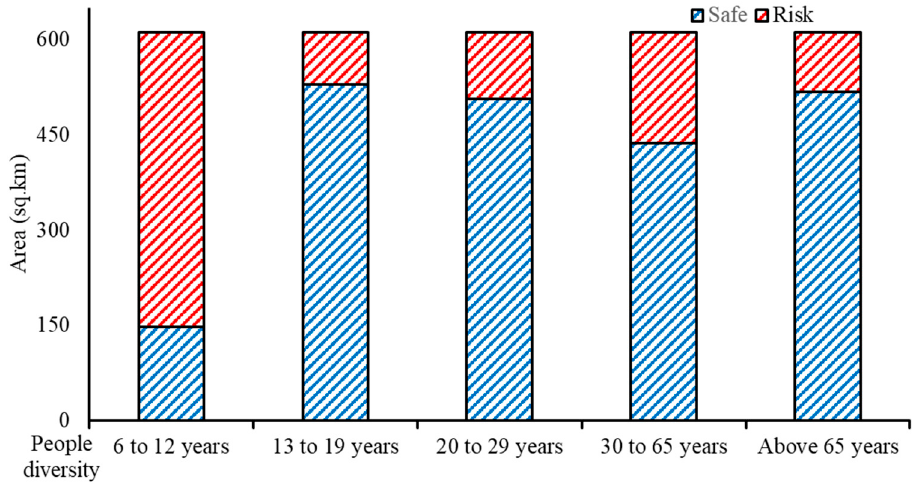
Figure 8. Non-carcinogenic risks for various groups of people in the study area.